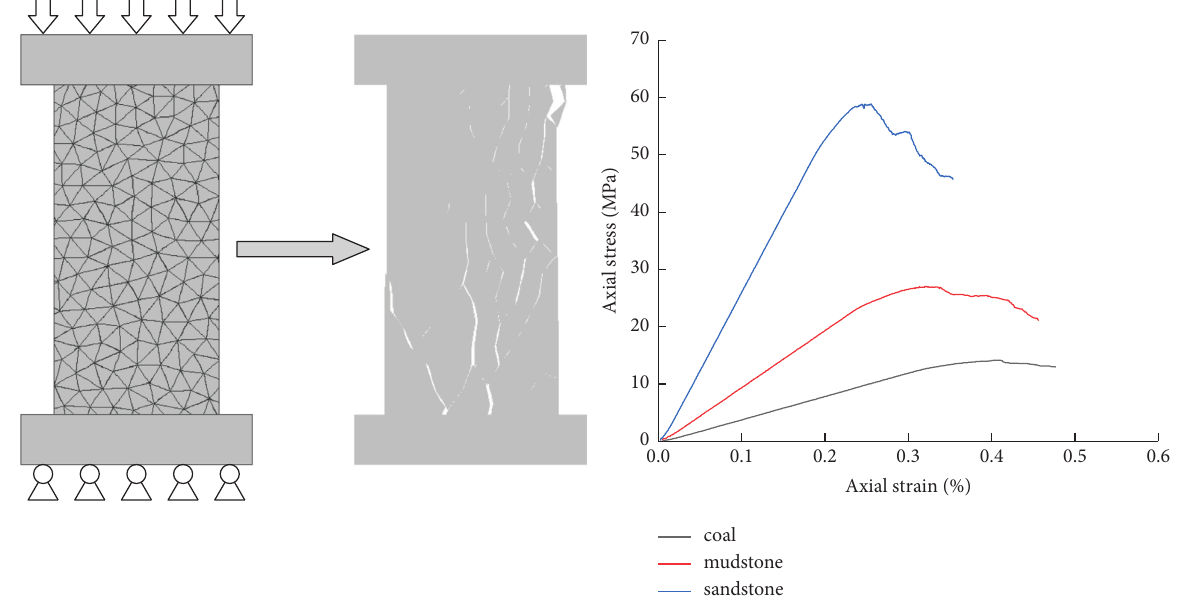
Figure 4: Calibration of mechanical parameters. Table 2: Mechanical parameters of blocks.